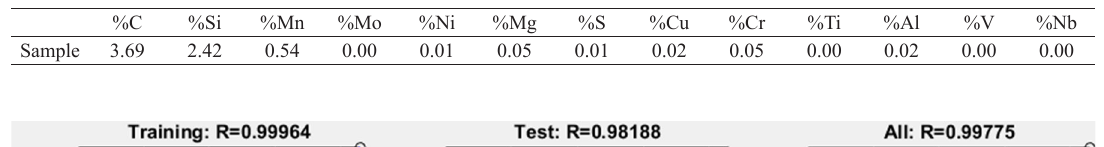
Table 3. Manufactured chemical composition ADI alloy (wt%).